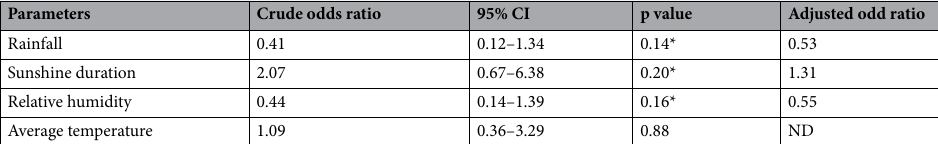
Table 3. Univariates and multivariable logistic regression demonstrate association between B. pahangi infection and environment parameters. ND not determined, *p > 0.20.